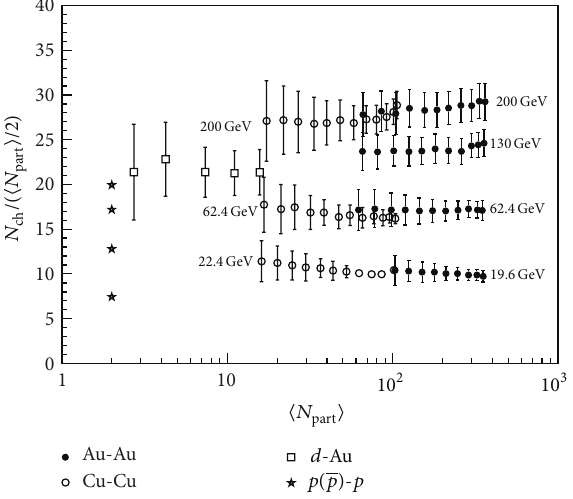
Figure 6: Charged hadron multiplicity per participant pair /⟨𝑁 /2⟩ ) as a function of 𝑁 at different √𝑠 𝑁𝑁 for 𝐴 - 𝐵 ( 𝑁 ch part part collisions [116, 120–122]. Inelastic 𝑝(𝑝) - 𝑝 data or interpolations to = 2 taken from [120, 123, unmeasured energies with 𝑁 part